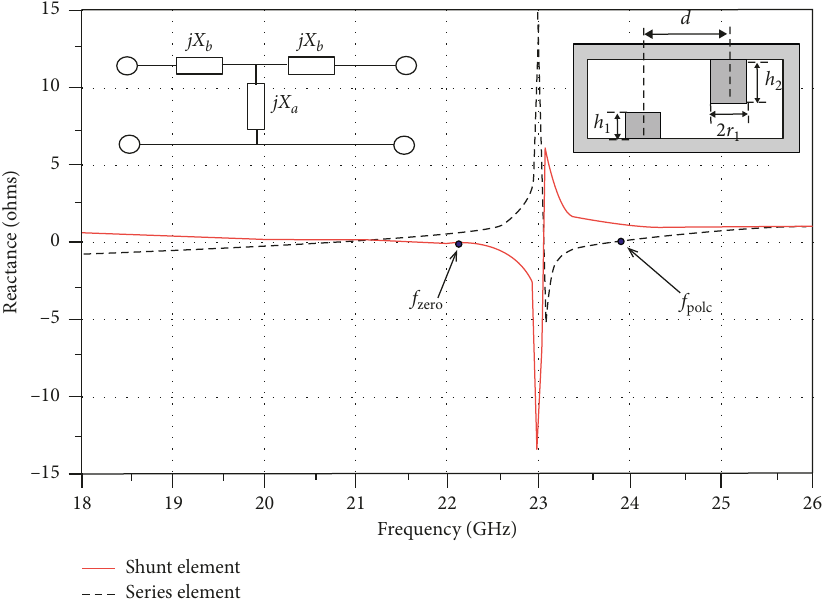
Figure 3: The dual-post resonator reactance for r